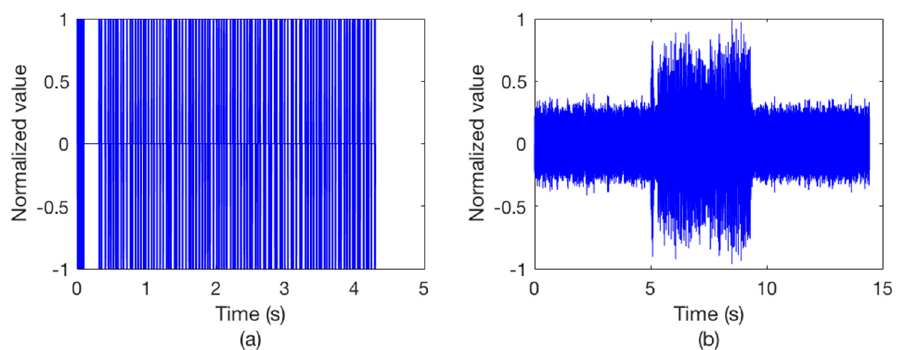
Figure 5. The waveforms of the packets. ( a ) The input packet; ( b ) the output packet after bandpass filtering, with a SNR of 5 dB in the frequency band.